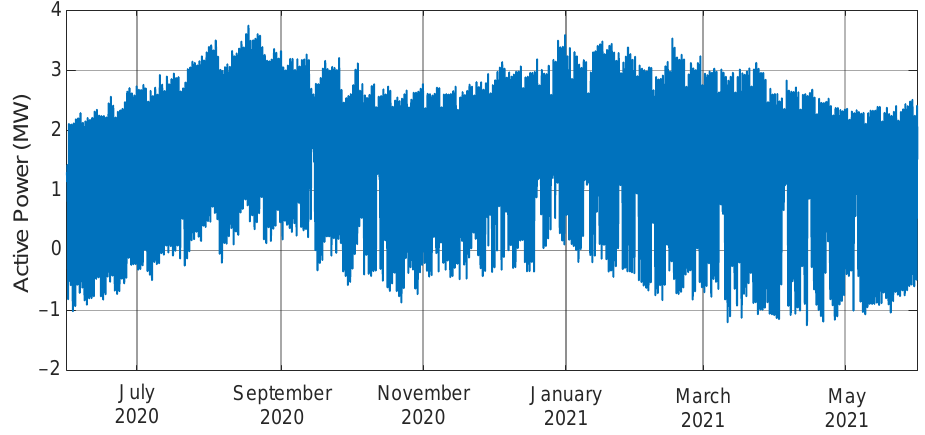
Figure 1. Daily net-demand curve for the period June 2020 to May 2021.